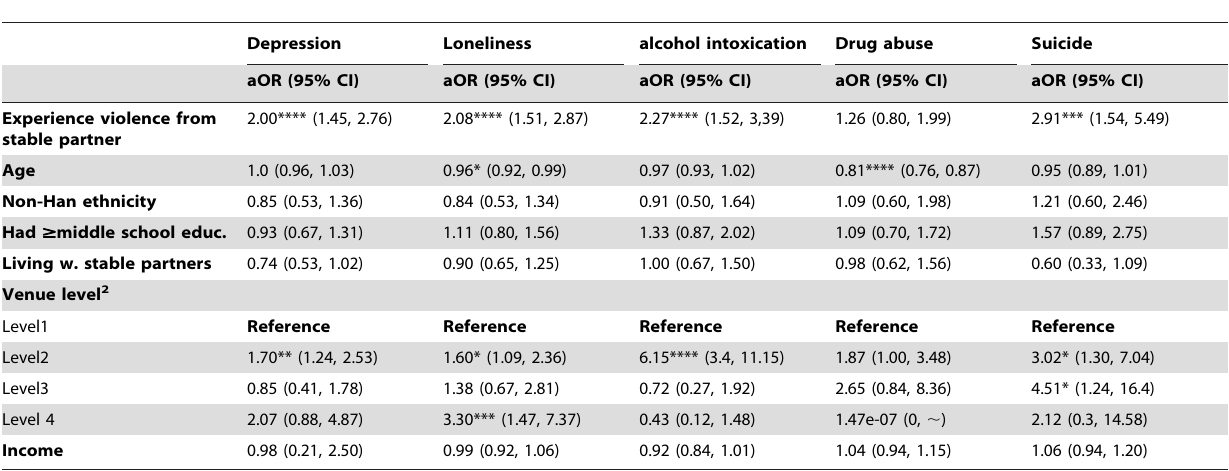
Table 4. Multivariate regression 1 of psychosocial distress indicators on partner violence from stable partners (n=743) 1 .